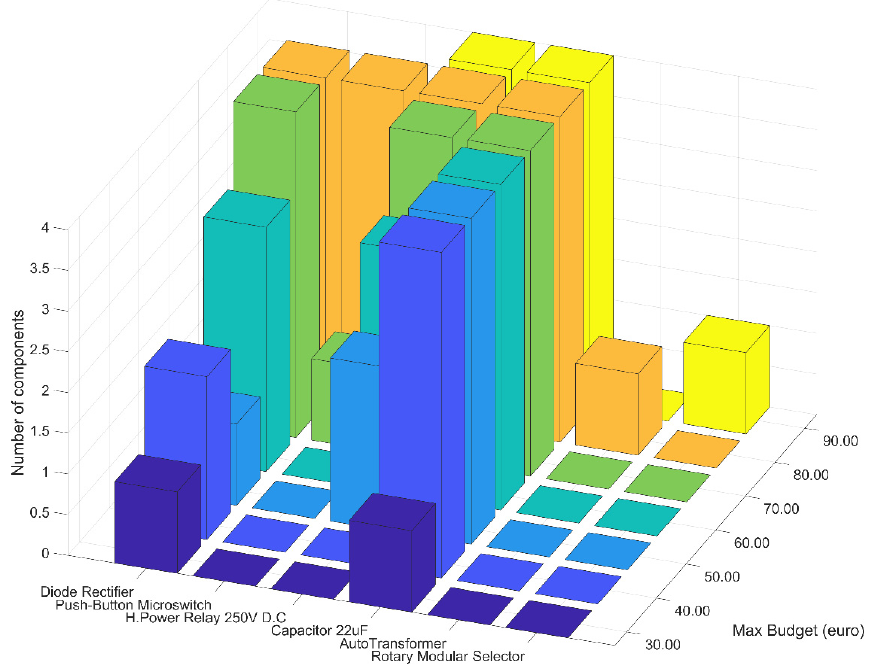
Figure 4. Graphical representation of PCB components considering different maximum client budgets for a dishwasher machine and differentiating the cost of Diode Rectifiers, H. Power Relays, Capacitors and Rotary Modular Selectors to 1.60 EUR, 6.30 EUR, 2.65 EUR and 26.58 EUR, respectively.